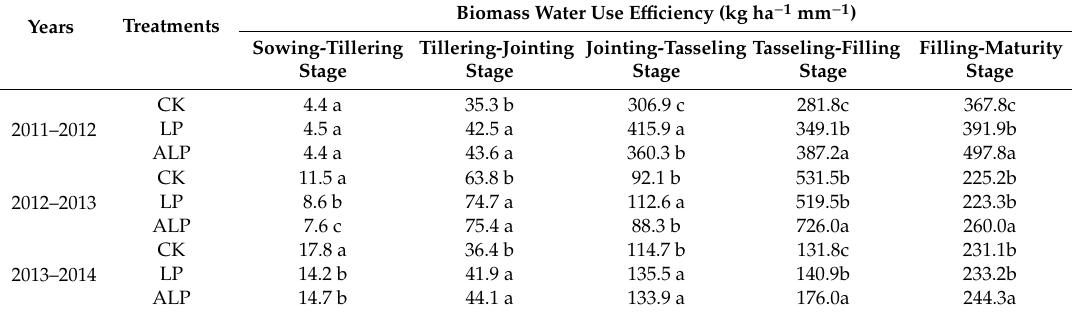
Table 6. E ff ects of di ff erent straw incorporation treatments on biomass water use e ffi ciency at di ff erent growth stages of winter wheat.